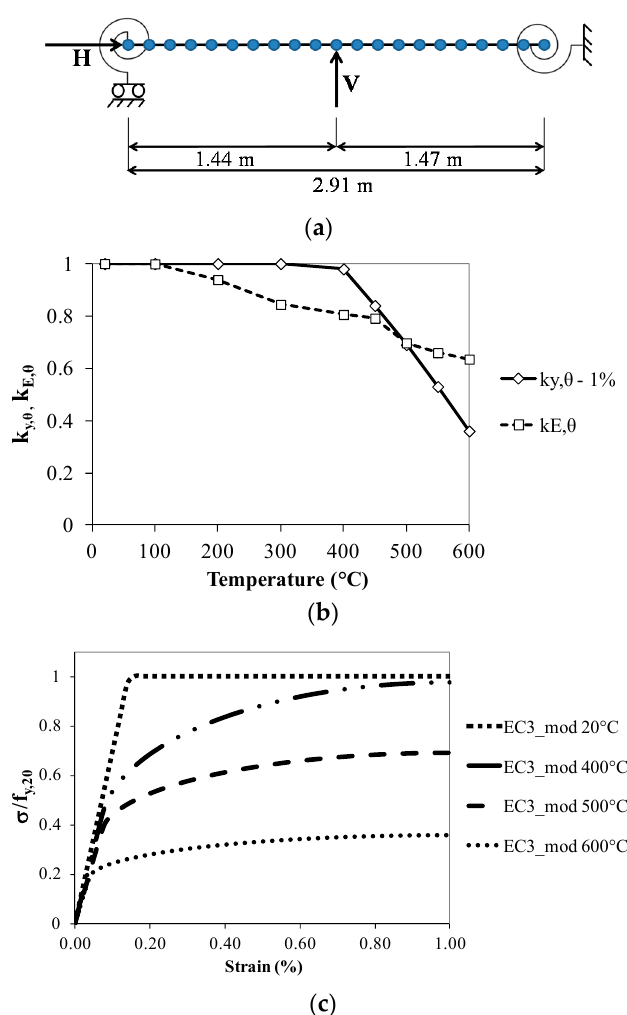
Figure 5. Column model and the selected material models: ( a ) column model and FE mesh; ( b )